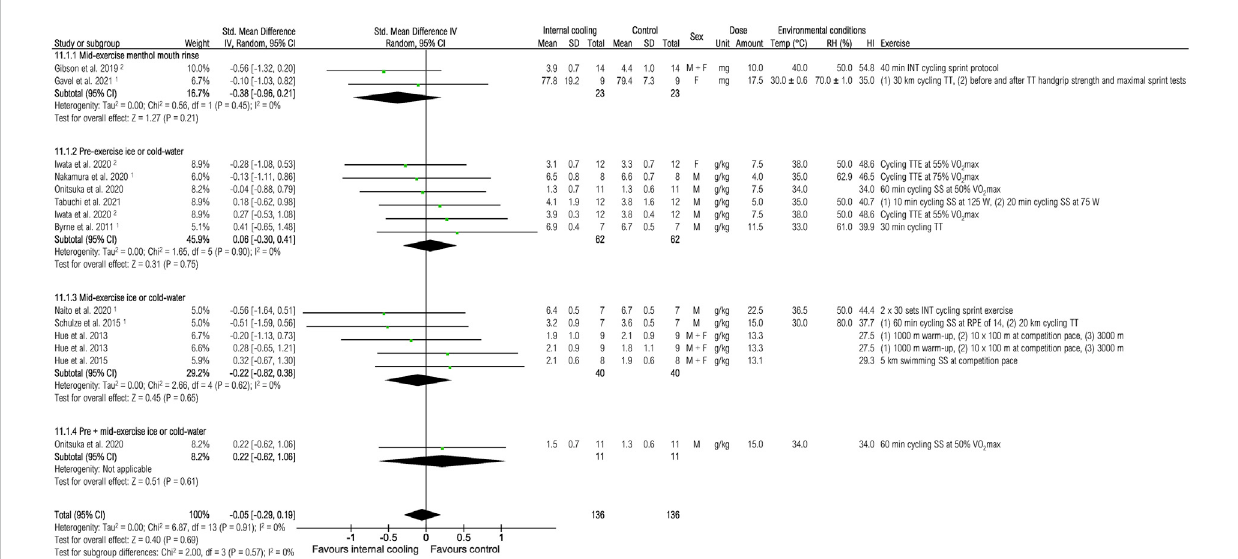
FIGURE 12 Meta-analysis of standardized mean difference in thermal comfort with 95% CI between internal cooling and control. 1 Studies with signi fi cant positive performance effects of internal cooling. 2 Studies with no performance effects of internal cooling. F, female; HI, heat index; INT, intermittent exercise;M,male;RH,relativehumidity;RPE,rateofperceivedexertion;SS,steady-stateexercise;Temp,ambienttemperature;TT,timetrial;TTE,timeto exhaustion; VO 2 max, maximum oxygen consumption.